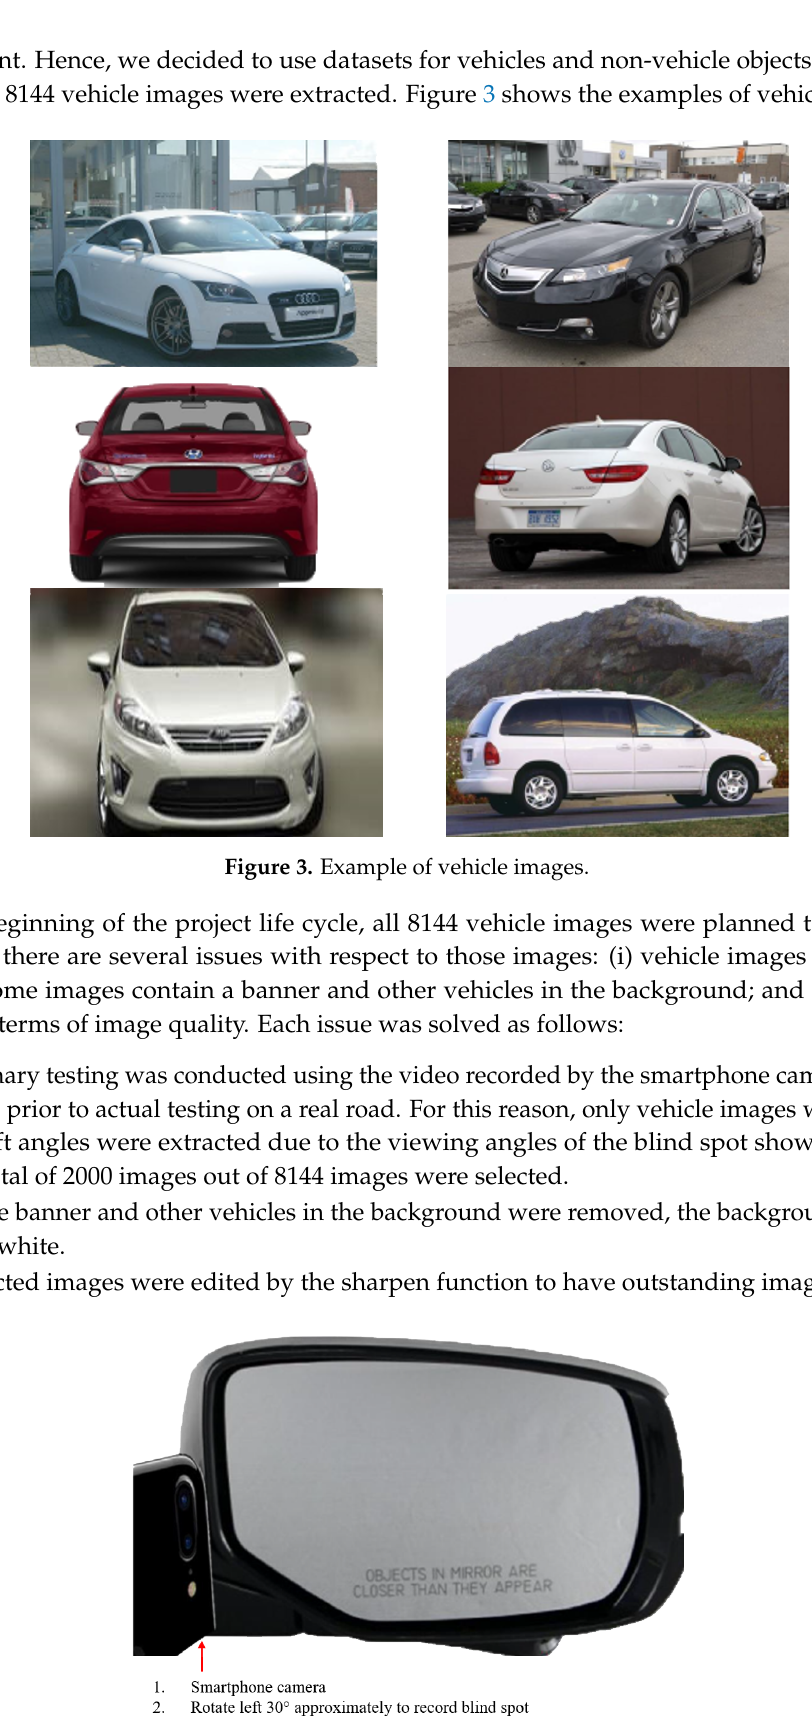
Figure 4. Camera installation for preliminary